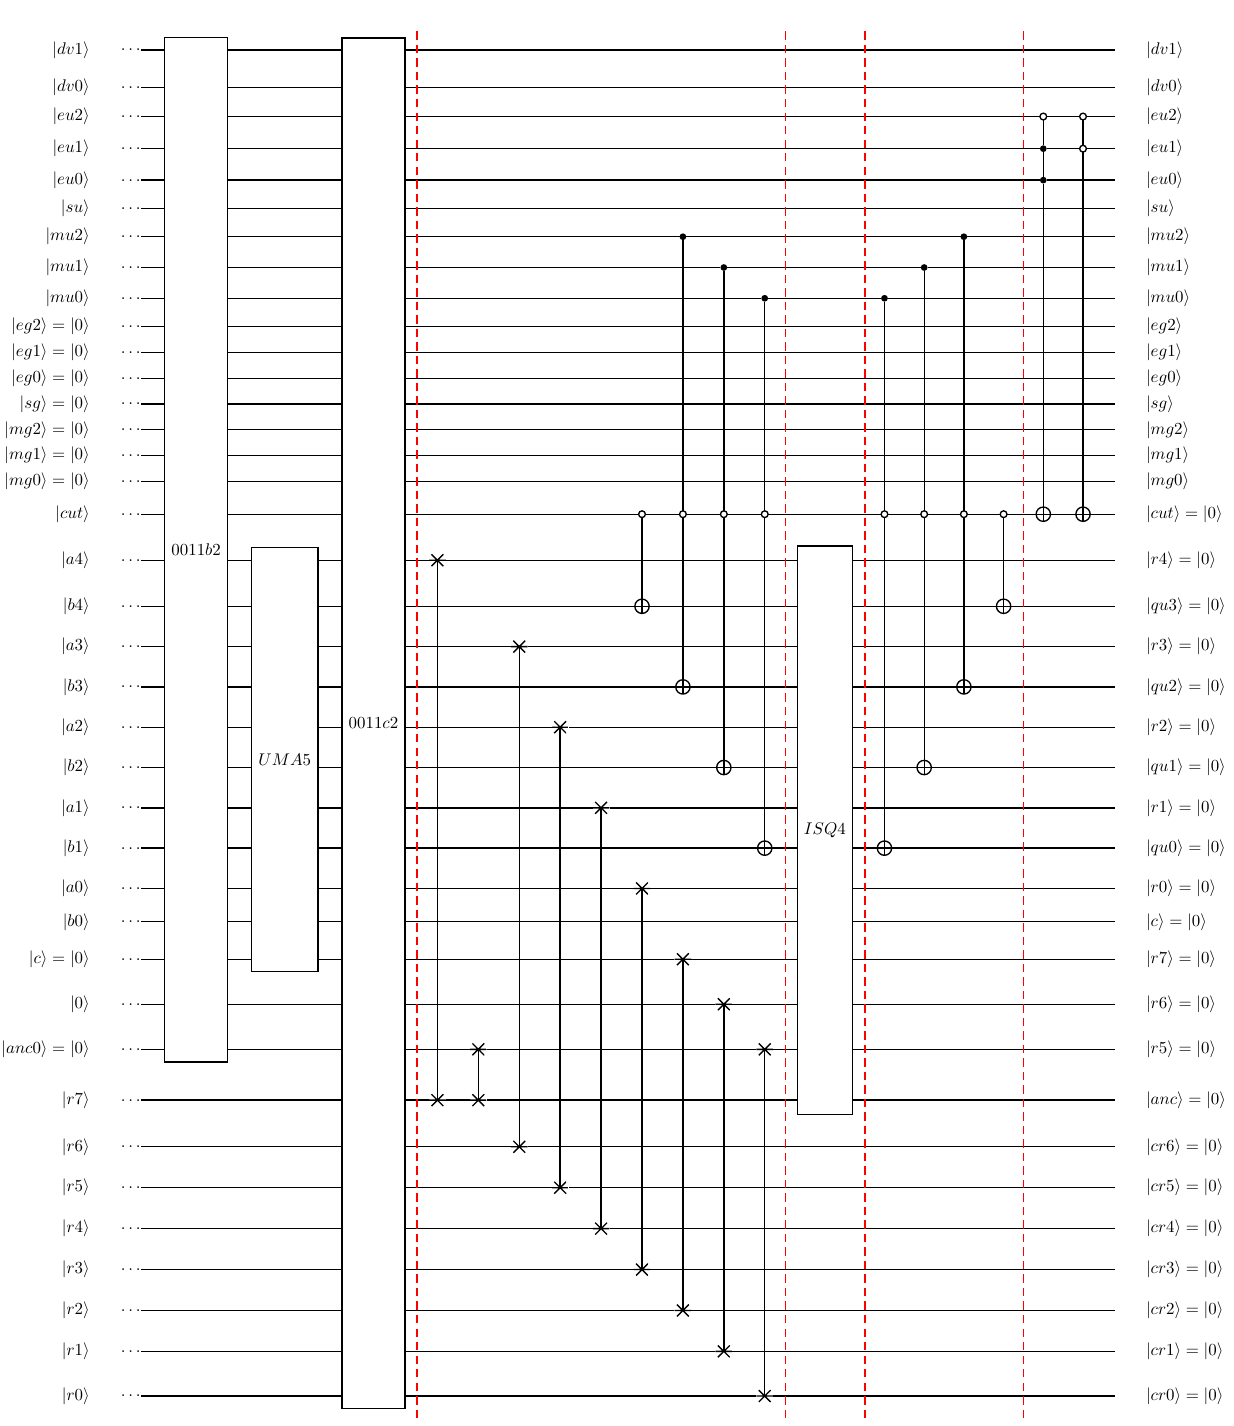
Figure 4. Modified D1Q3 model: quantum circuit design for computing (cid:126) g eq . Floating-point represen- tation uses four mantissa qubits ( N M = 4) and three exponent qubits ( N E = 3), with an exponent bias set to eight. Part